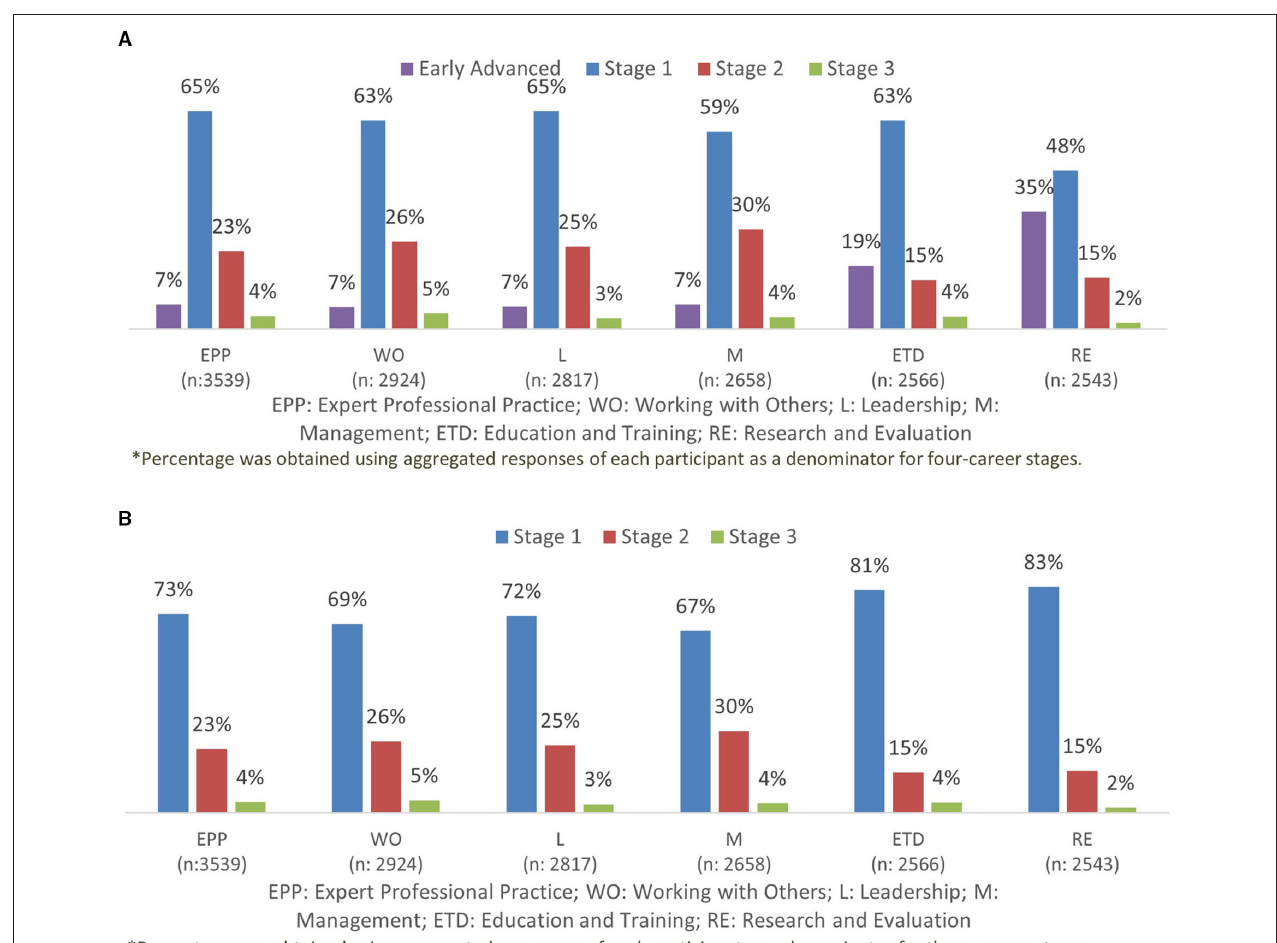
FIGURE 2 | (A) Four career stages. (B) Three career